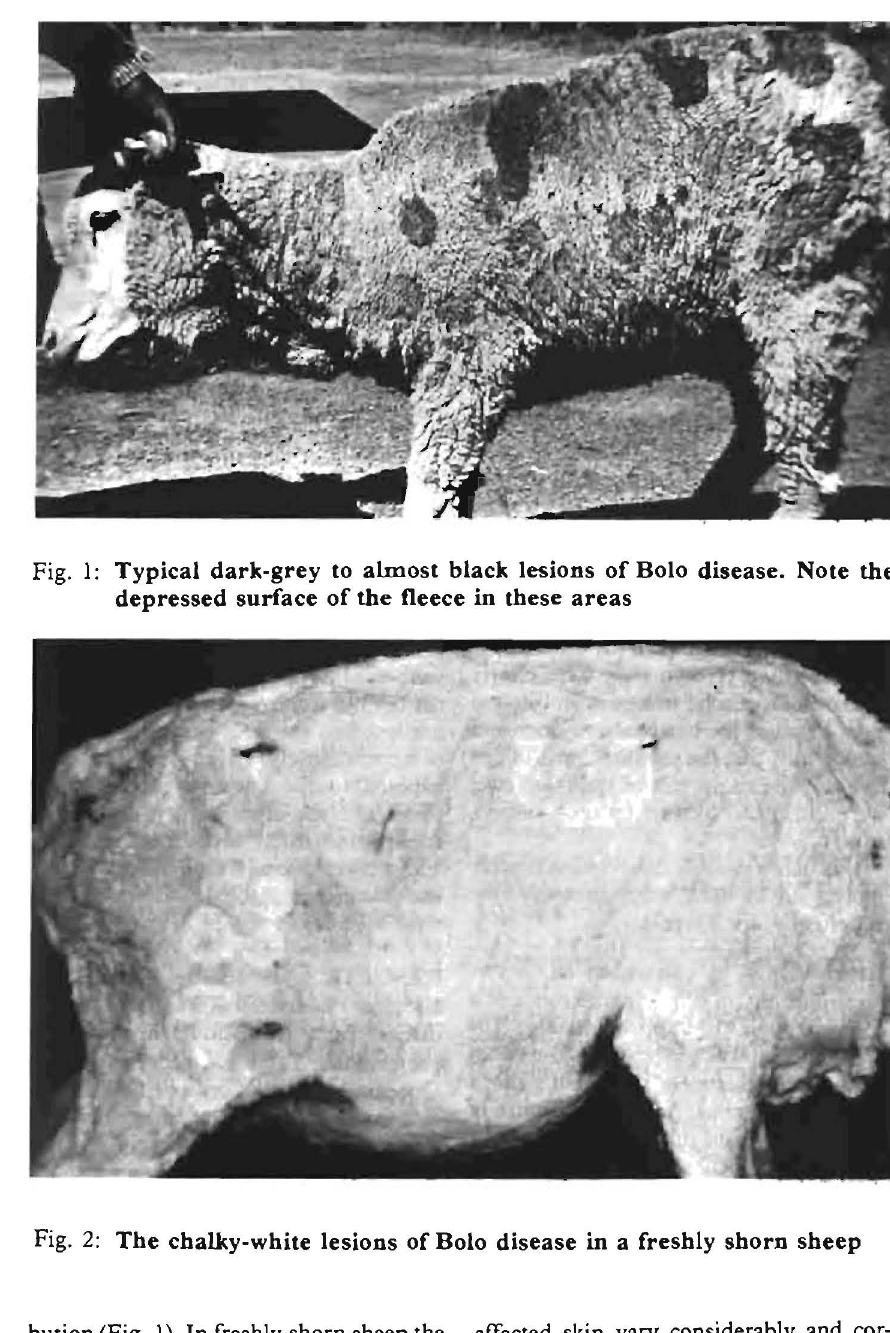
but ion (Fig. 1). In freshly-shorn sheep the affected areas are chalky-white 5 22 (Fig. 2). The wool in the affected areas is visibly shorter than elsewhere on the body, less dense and tender. When the wool is par ted, yellowish to greyish-white, sticky, scaly deposits are found adjacent to the skin and in between the wool fibres caus ing the wool to stick together, resulting in a spiky